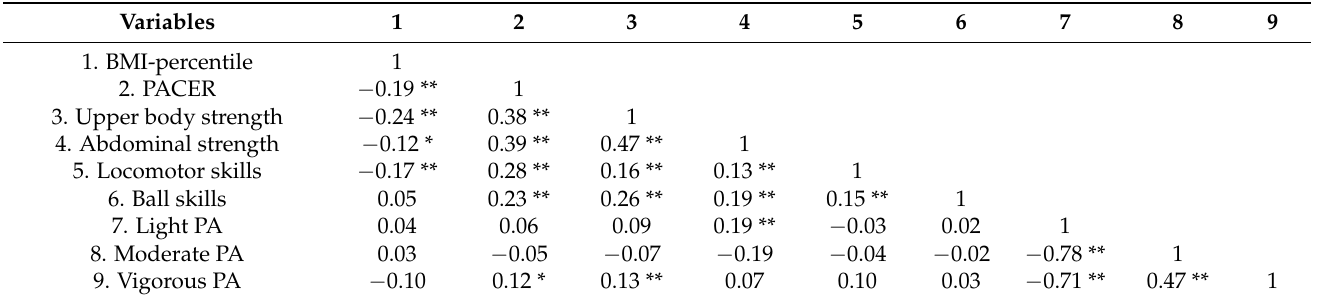
Table 2. Pearson Correlation Matrix of the Variables (N = 342).